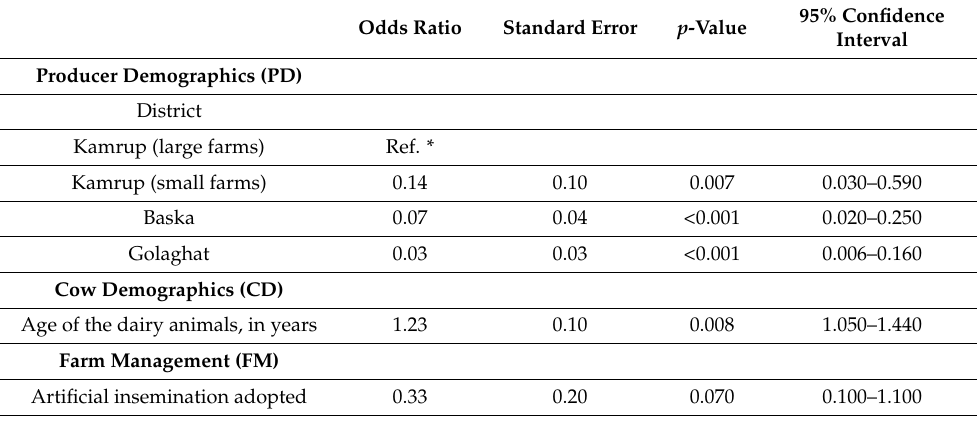
Table 4. Results of the four sub-models used in the analysis.